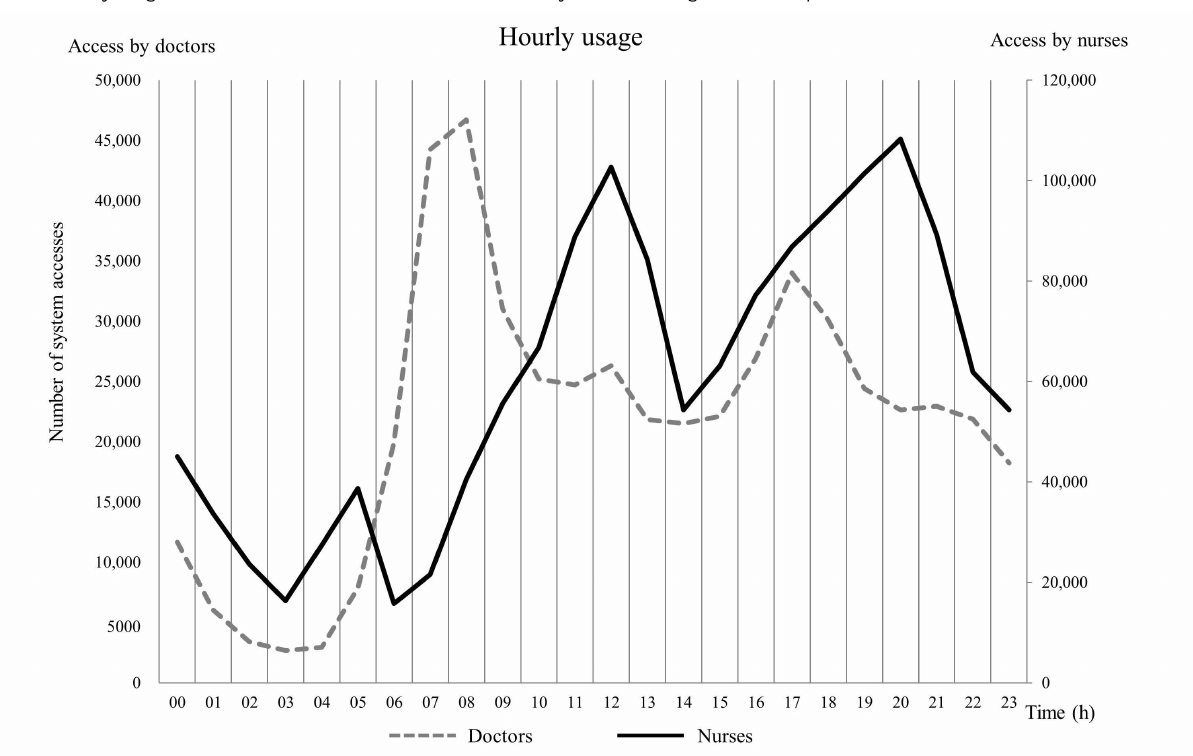
Figure 4. Hourly usage trends of mobile Asan Medical Information System according to user occupations.